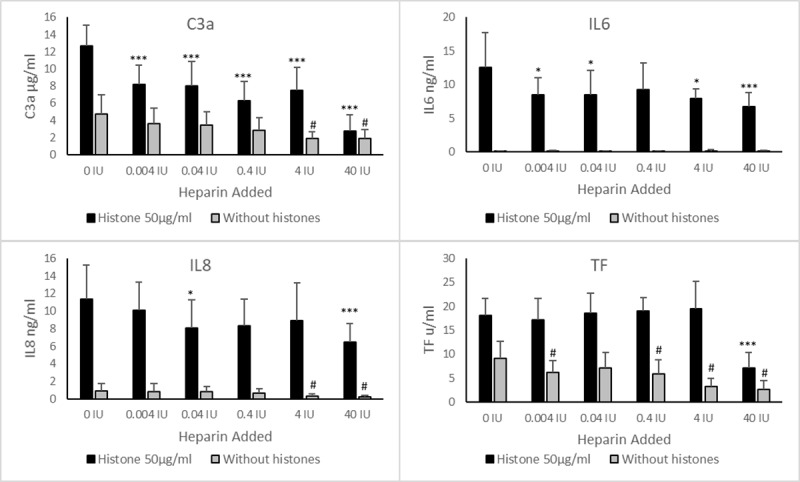
Effect of heparin on background and histone induced inflammatory responses in whole blood.Increasing concentrations of heparin (in International Units) were added to whole blood treated with/without 50 μg/ml histones and incubated for 6 hours. Released C3a, IL-6 and IL-8 were measured in plasma and tissue factor was measured from the cellular component. Analysis of each group (with/without histones) by Dunnett’s multiple comparison was carried out using the background (0 IU) as the control group, * or # = p < 0.05, ** or ## = p < 0.01, *** or ### = p <0.001. Error bars = standard deviation of the average from 6 donors.